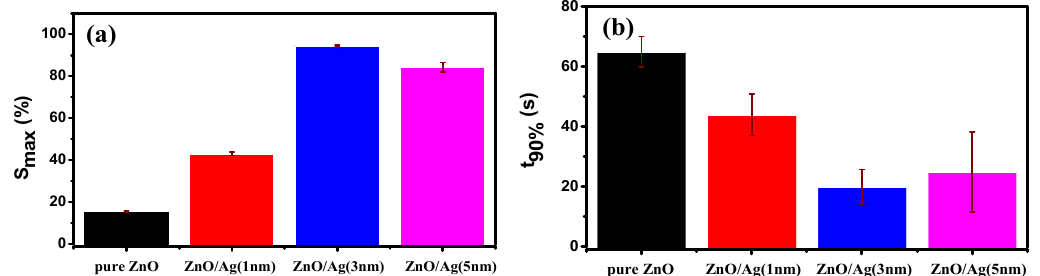
Figure 7. Sensing performance comparison of the annealed ZnO films with or without Ag layers: ( a ) gas response of ZnO films at 333 ppm of NH 3 ; ( b ) response time for the resistance dropping 90% of the initial value.